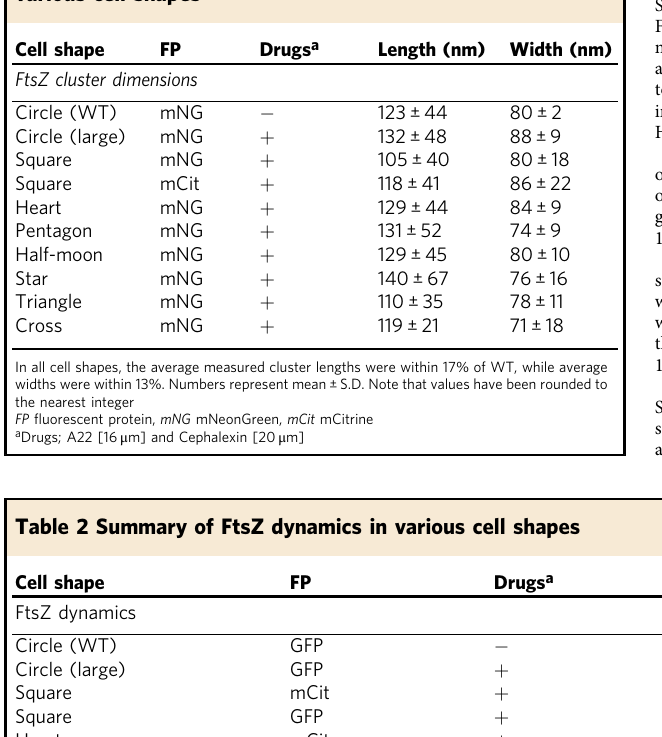
Figure 3). Pillar arrays (1 ×1 cm) with square pillars contained micron-sized pillars approximately every 5 μ m, with side lengths varying between 1.8 and 3.5 μ m, and heights of 5.5± 0.5 μ m (Supplementary Figure 11). To create more complex shapes, a second approach, based on electron beam lithography was used. For this, the micron-scale structures were fabricated on a Si substrate by a multi-step process, which was a combination of electron beam lithography and reactive ion etching techniques. Similar approaches to silicon patterning have been successfully used in a number of earlier works 48 – 51 . First, a pattern of e-beam resist was created on a Si surface using e-beam lithography. A 50 nm-thick Ti layer was then deposited, and a lift-off process was used to create a metal mask for etching. The use of a metal mask, instead of a baked e-beam resist mask, was necessary due to the high selectivity ratio required for generating structures only a few microns in height. Finally, the etching process was performed as described above, using an Oxford Plasmalab100 ICP180 CVD/Etch system and a mixture of SF 6 and O 2 plasma as an etchant. For our process, a SF6:O 2 fl ow ratio of 3:2 produced the best results, with a Si:Ti etching selectivity ratio of approximately 100:1. Increased concentration of O 2 in the mixture has two effects: (i) it improves etching anisotropy, which is essential for avoiding shape distortion from the undercut effect, and (ii) it reduces the selectivity ratio, as the Si etch rate gets slower. After etching, the structures were characterized using a Dektak surface